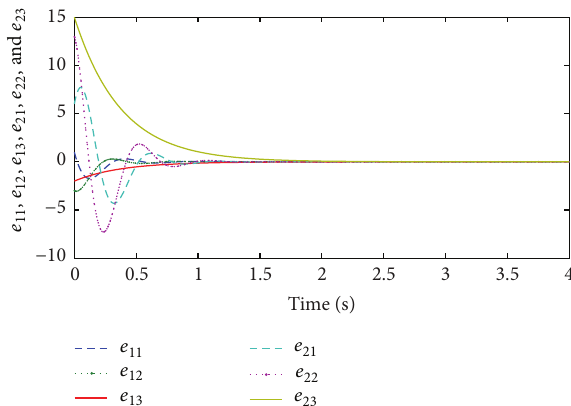
Figure 1: Dynamics of the variables 𝑒 11 , 𝑒 12 , 𝑒 13 , 𝑒 21 , and 𝑒 22 and 𝑒 23 of the error systems 𝑒 1 and 𝑒 2 with time 𝑡 .